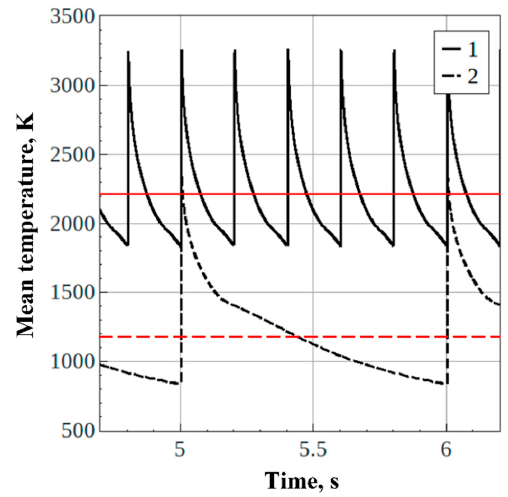
Figure 3. Calculated time histories of mean temperature in the flow reactor at pulsed detonation gun operation with a frequency of f = 5 (1) и 1 Hz (2) without waste feed: T w = 450 K, P = 0.1 MPa.